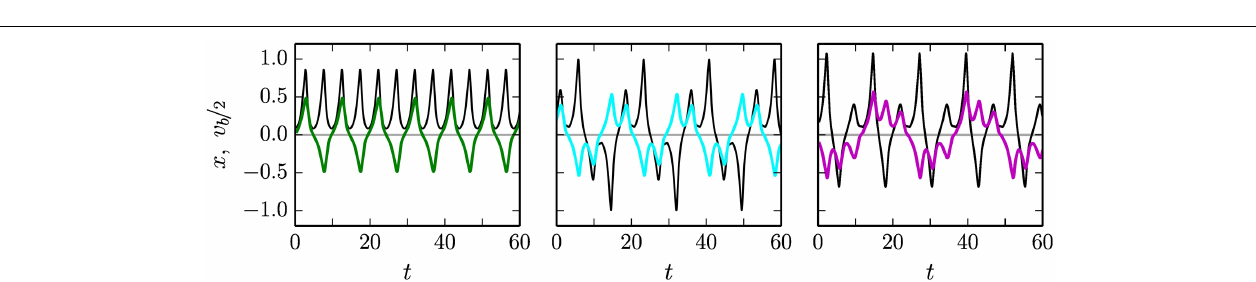
FIGURE 6 | The time evolution of the position x (colored lines) of the mass along the rod, and of the (rescaled) speed v b of the barrel (black lines), for a =1.9 and """ =0.019/0.017/0.015 (left/center/right), all in the off mode (compare Figure 5) . The respective average velocities are < v b > = 0.63/0.00/0.25 for the 1:1 mode (left), the stationary back-and-forth mode (middle), and the drifting back-and-forth mode (right). For the corresponding videos, see the Supplementary